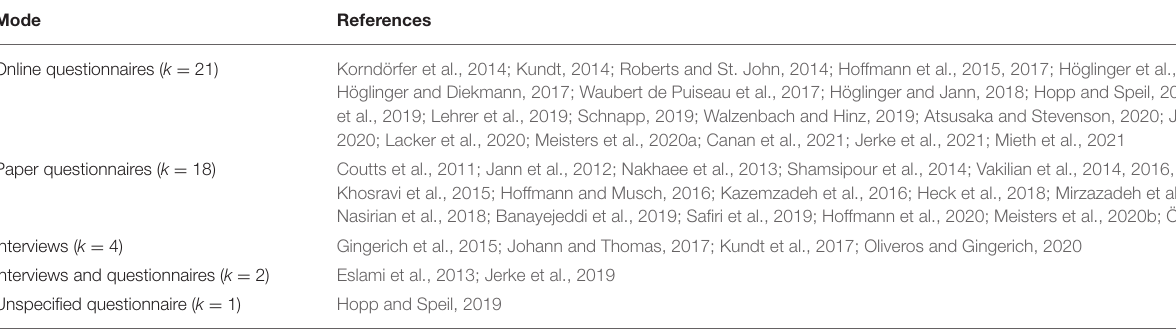
TABLE 2 | Mode of CM administration.